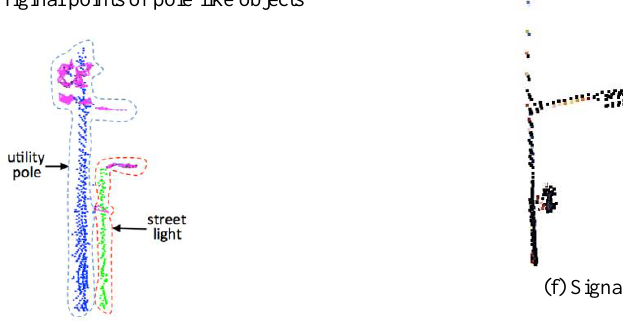
Figure 11. Original points of pole-like objects